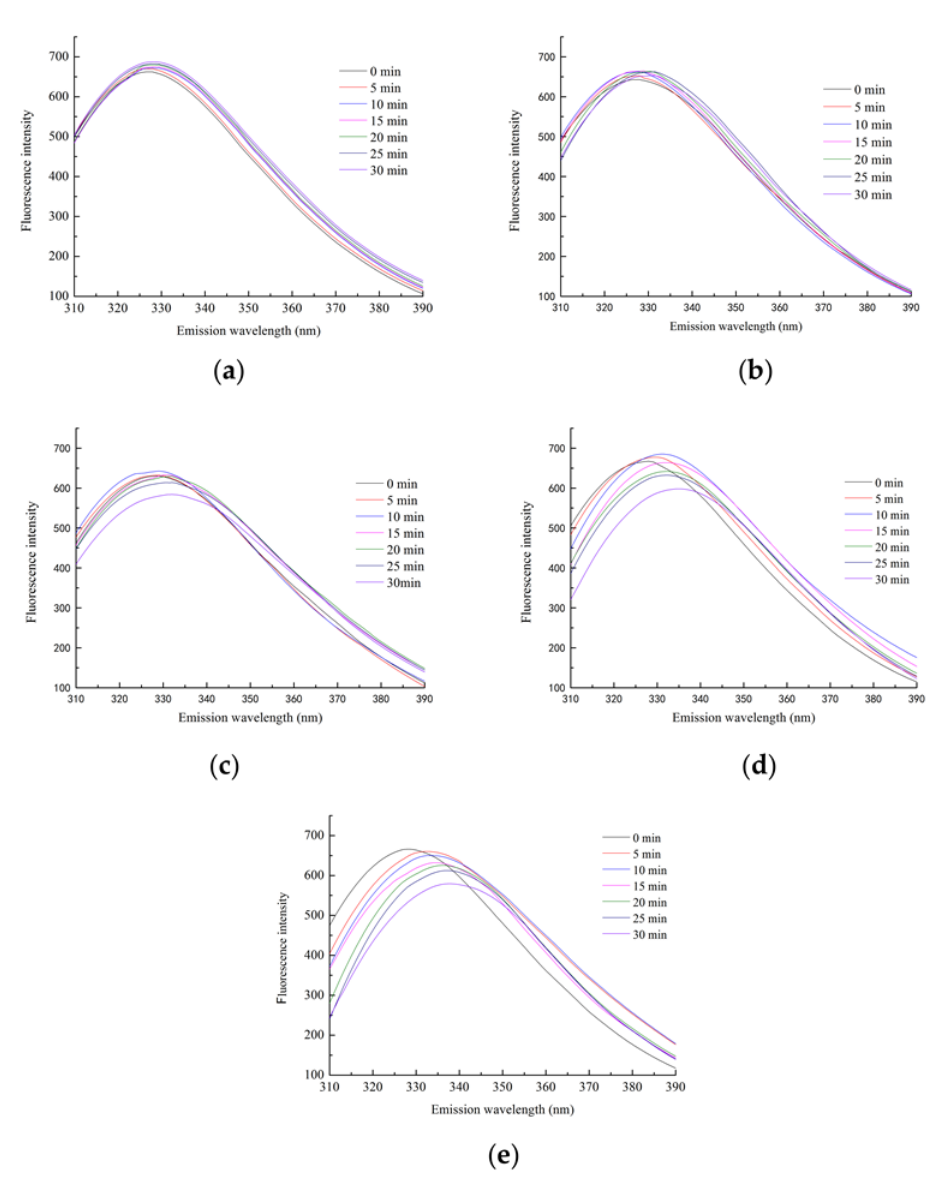
Figure 5. The intrinsic fluorescence spectra of lectin at ( a ) 50 °C, ( b ) 60 °C, ( c ) 70 °C, ( d ) 80 °C, and ( e ) 90 °C.